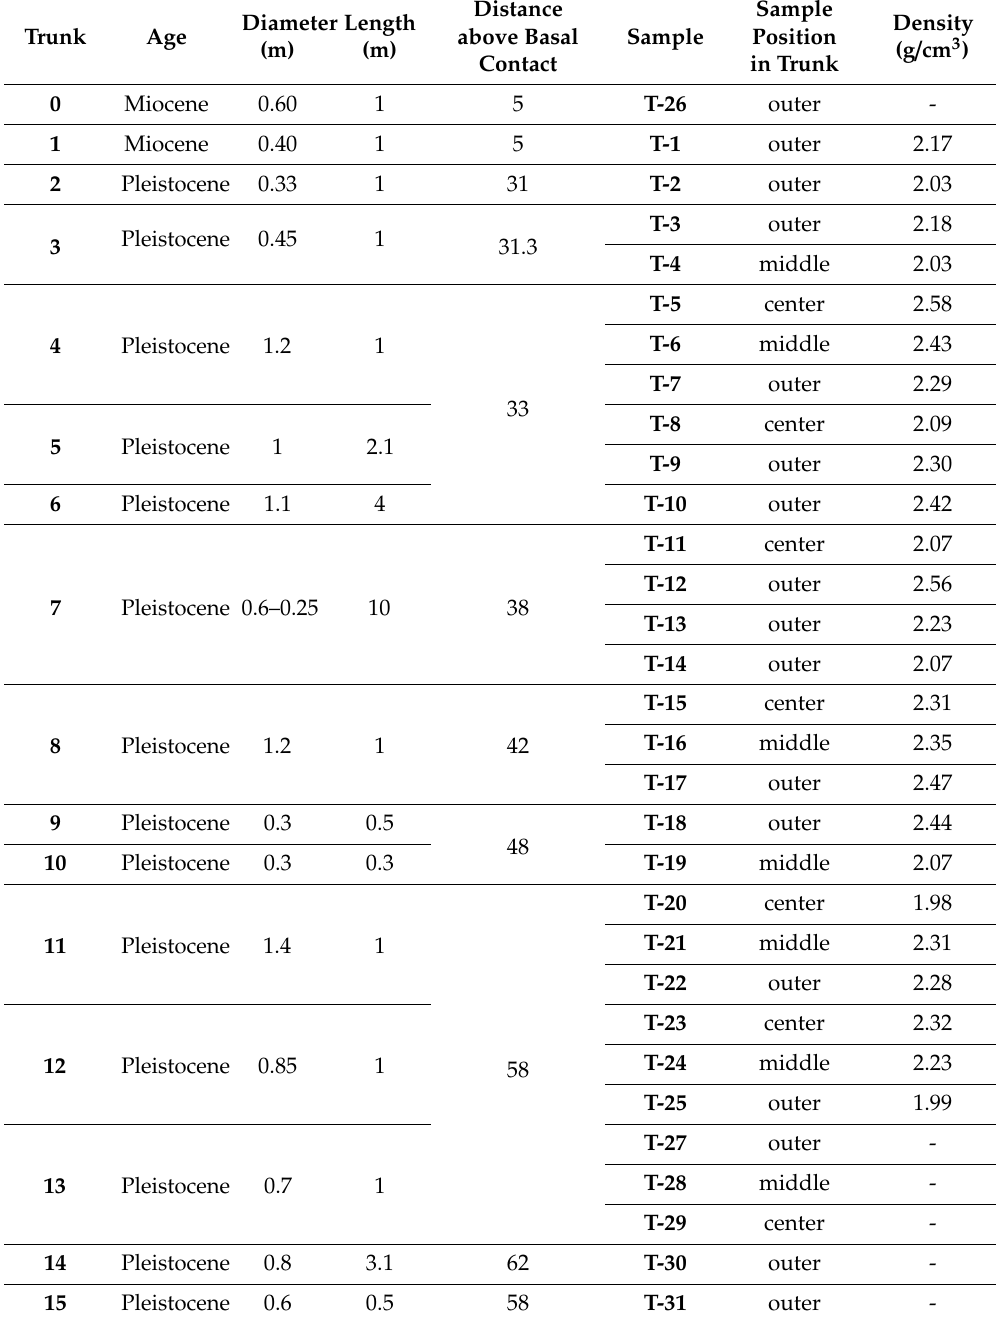
Table 1. Location and Description of Fossil Tree